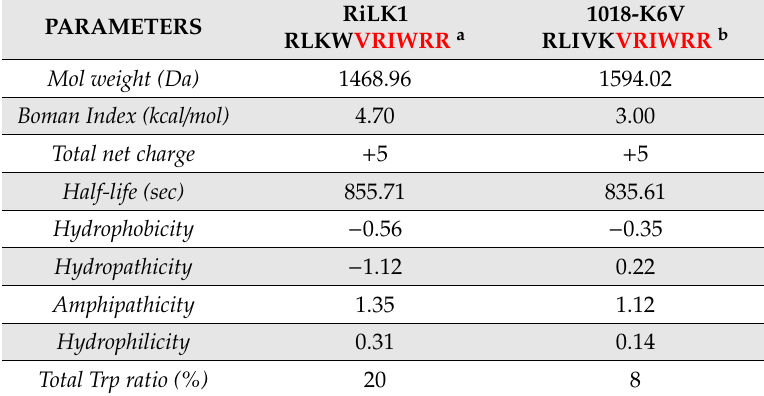
Table 1. List of the physicochemical properties calculated and predicted for the designed peptide RiLK1 in comparison with those of the parent AMP